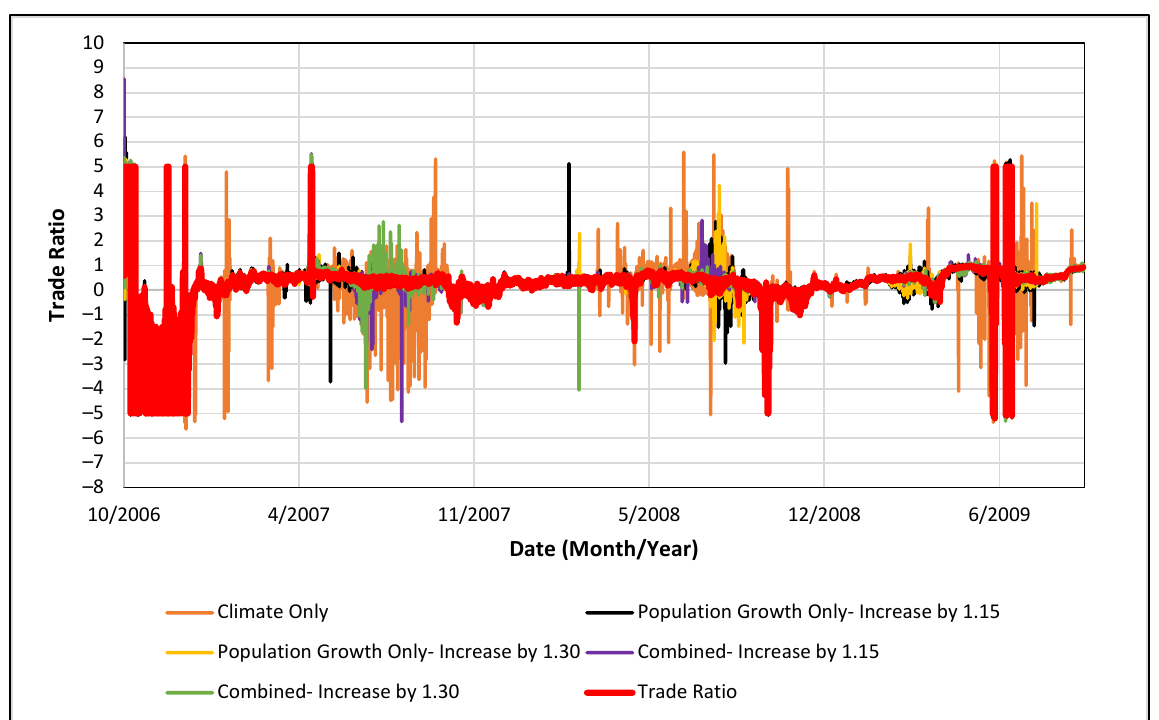
Figure 9. Composite Trade Ratio based on Sums for Delivery + Downstream Components with Equivalency Adjustments for Theoretical WQT Buyer TP Combined with Suggested Margins of Safety for Climate and Population Characteristics over the Jordan River Simulation Period (1 October 2006 to 30 September 2009) for RCP 4.5.